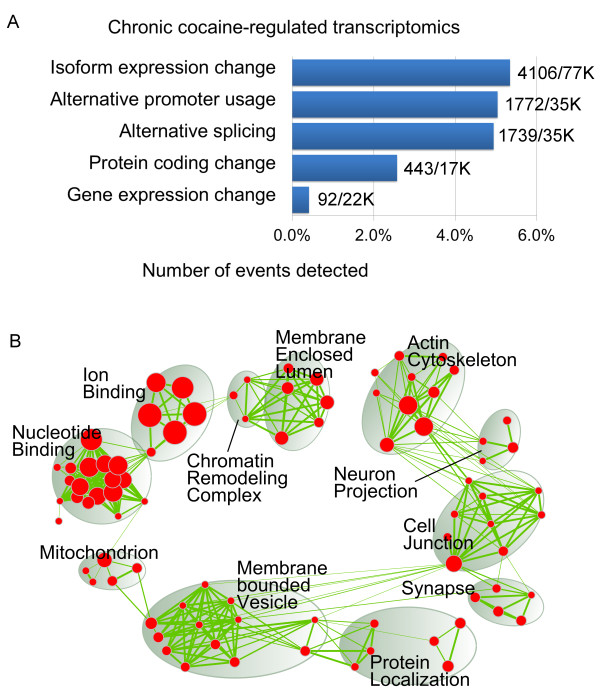
Chronic cocaine-induced transcriptome in mouse NAc. (A) Cocaine-regulated transcriptomic events versus total events illustrated as percentages (for example, 92 out of 22,000 genes show significant expression changes), which are based on Cuffdiff prediction (see Materials and methods). (B) Gene Ontology (GO) enrichment for differentially spliced genes is illustrated as an enrichment map
[26]: each node represents an enriched GO term and its size represents the number of genes; the color intensity of the node represents the statistical significance; the strength of the green lines represents the number of common genes shared between two nodes; the GO terms that are clustered together are circled and summarized with a name. Singletons are not shown; a full list of enriched GO terms is in Additional file
6.